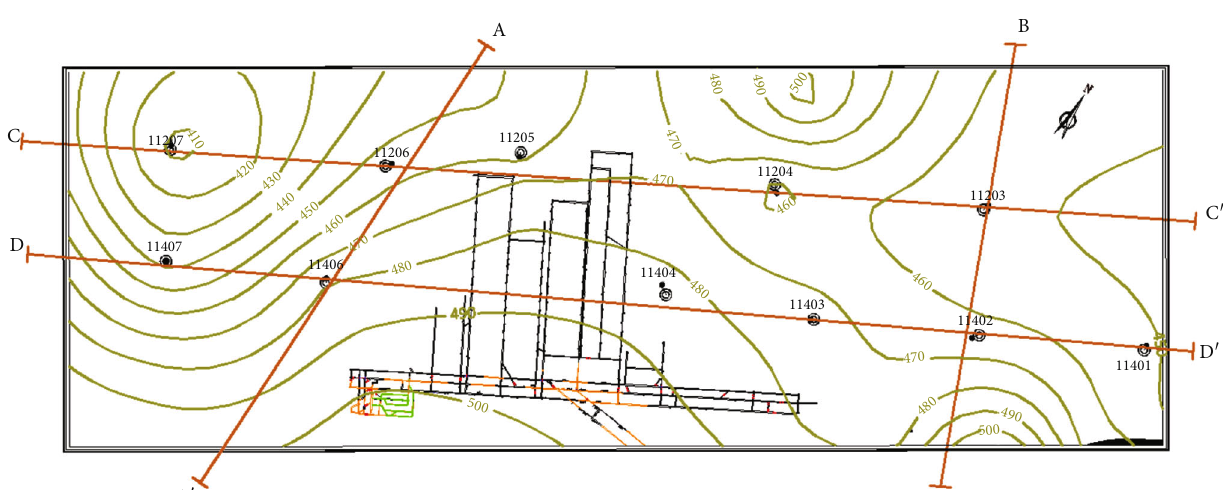
Figure 3: Contour map of the alluvium thickness of the north fl